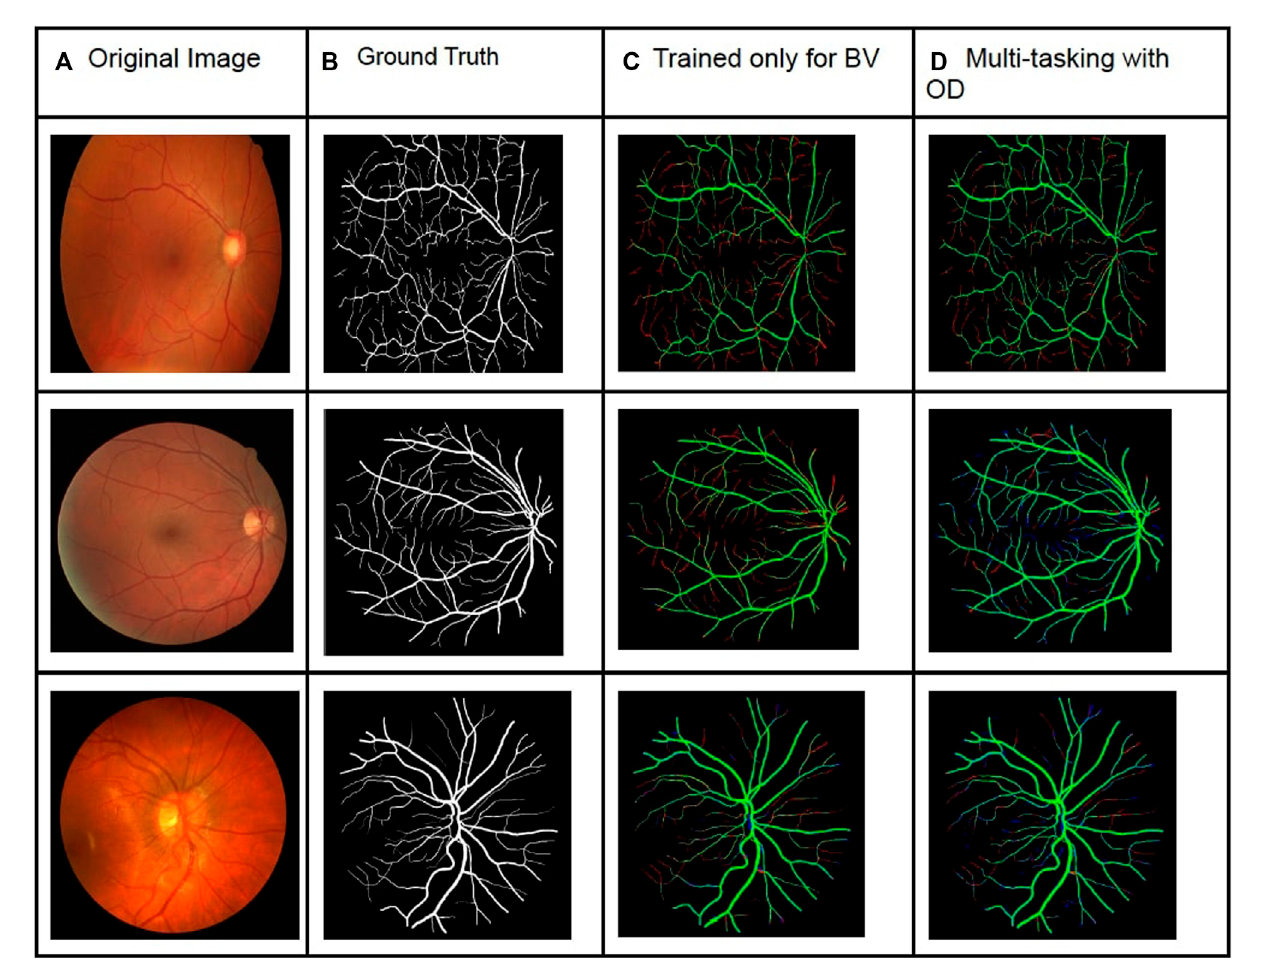
FIGURE 5 ComparisonofbloodvesselsegmentationresultsforHRF,DRIVE,andCHASE_DBdatasets(fromtoptobottomrow)withandwithoutmulti-tasking.The green pixels in the predicted image correspond to true positives, blue pixels correspond to false positives, and red pixels correspond to false negatives. An increase in F1score of4.67%, 3.31%, and 5.83% wasobserved inHRF, DRIVE, and CHASE_DB,respectively. The columns from leftto right show original image (A) , Ground Truth (B) , Prediction with model trained only for BV segmentation (C) and Prediction using model trained with OD and BV segmentation (D) .